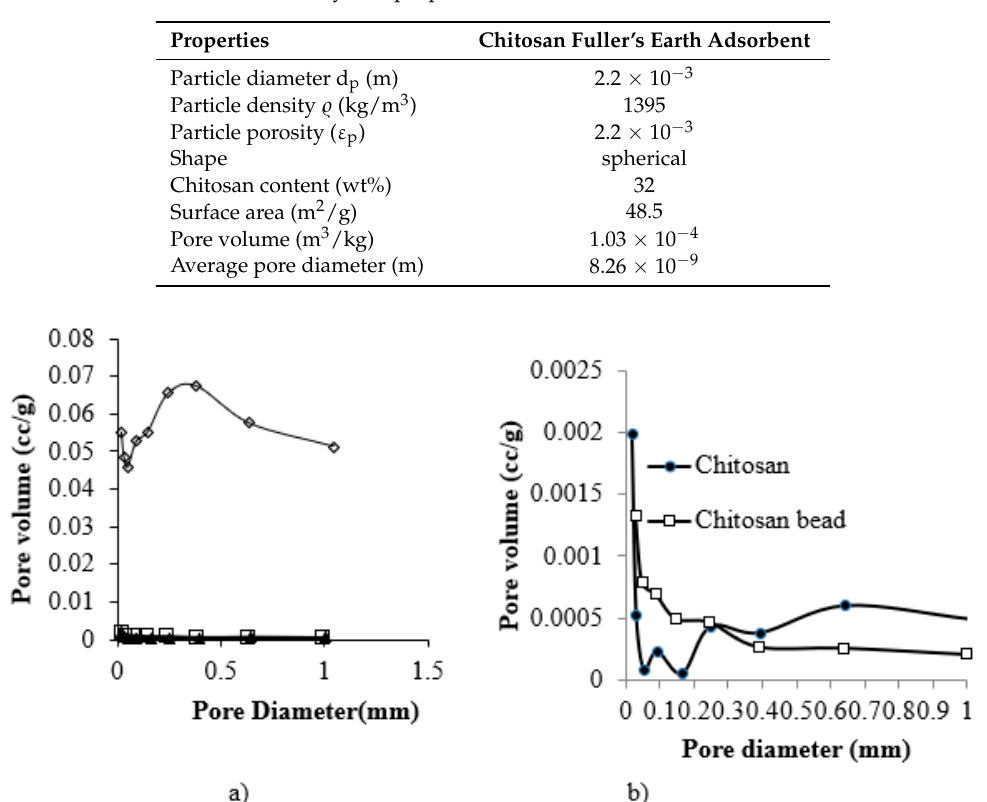
Figure 1. Scanning electron microscopy (SEM) micrograph: ( a ) pure chitosan bead, ( b ) CF bead, ( c ) Transmission electron microscopy (TEM) micrograph of the CF beads (the black spots represent Fuller’s earth particles), and ( d ) SEM micrograph of the CF beads after exposure to strontium solution. Table 2. Physical properties of the Fuller’s earth beads.